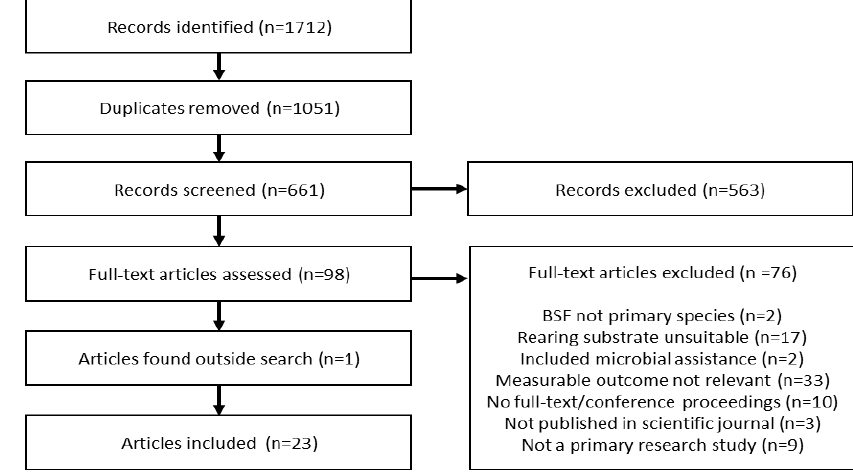
Figure 1. Flow diagram summarising the screening process.